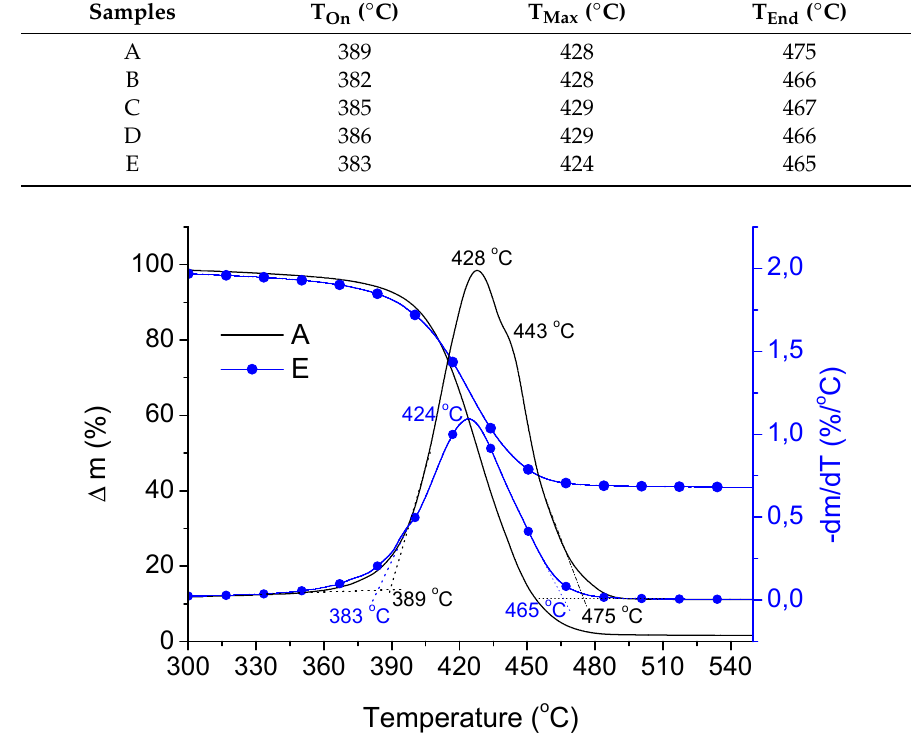
Table 3. Temperatures at onset (T On ), end (T End ) and maximum rate (T max ) of mass loss determined